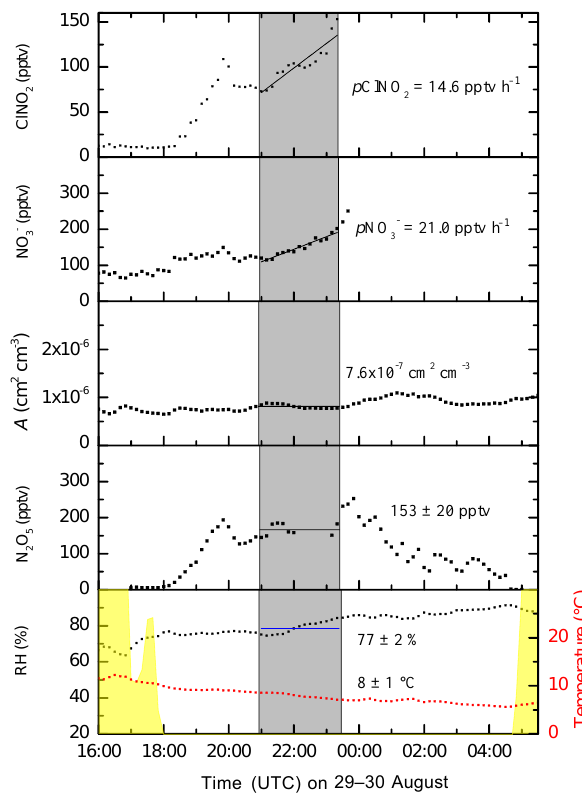
Figure 7. Plot demonstrating the derivation of f and γ from ClNO 2 and NO − measurements using analysis method 1c. The red lines are 3 were mea- the predicted, integrated concentrations of NO − 3 lated using the summed particle surface area ( A ) from both coarse and fine particles. In this particular case, the analysis returns a value of γ = 0.085 and f = 0.33. The relative humidity over this period was 82 ±